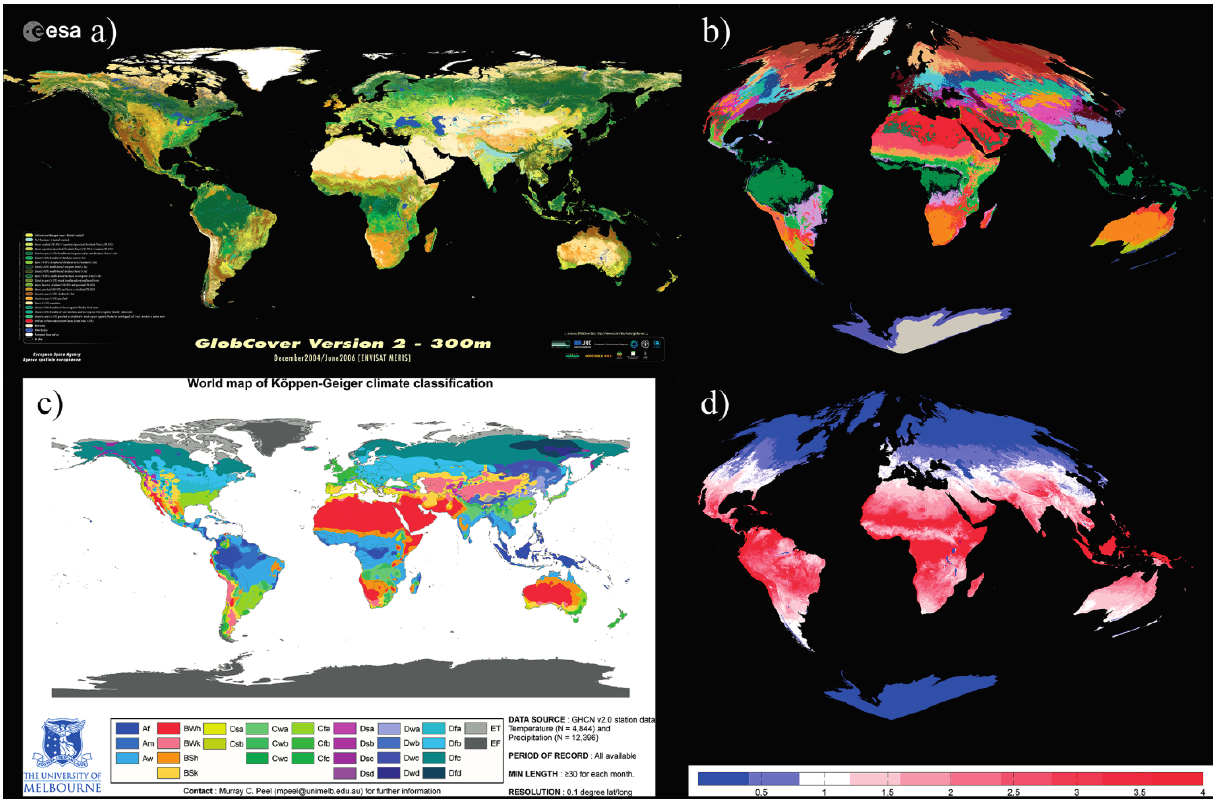
Figure 8. ( a ) ESA GlobCover. Map may be used freely, © ESA/ESA GlobCover Project, MEDIAS France/Postel; ( b ) k-means clustering of ACP with 30 clusters in random color-map; ( c ) Effective climate classification after Köppen & Geiger by Murrat Peal and colleagues [54] © CC BY-SA 3.0 ( d ) diurnal (red) and seasonal (blue)